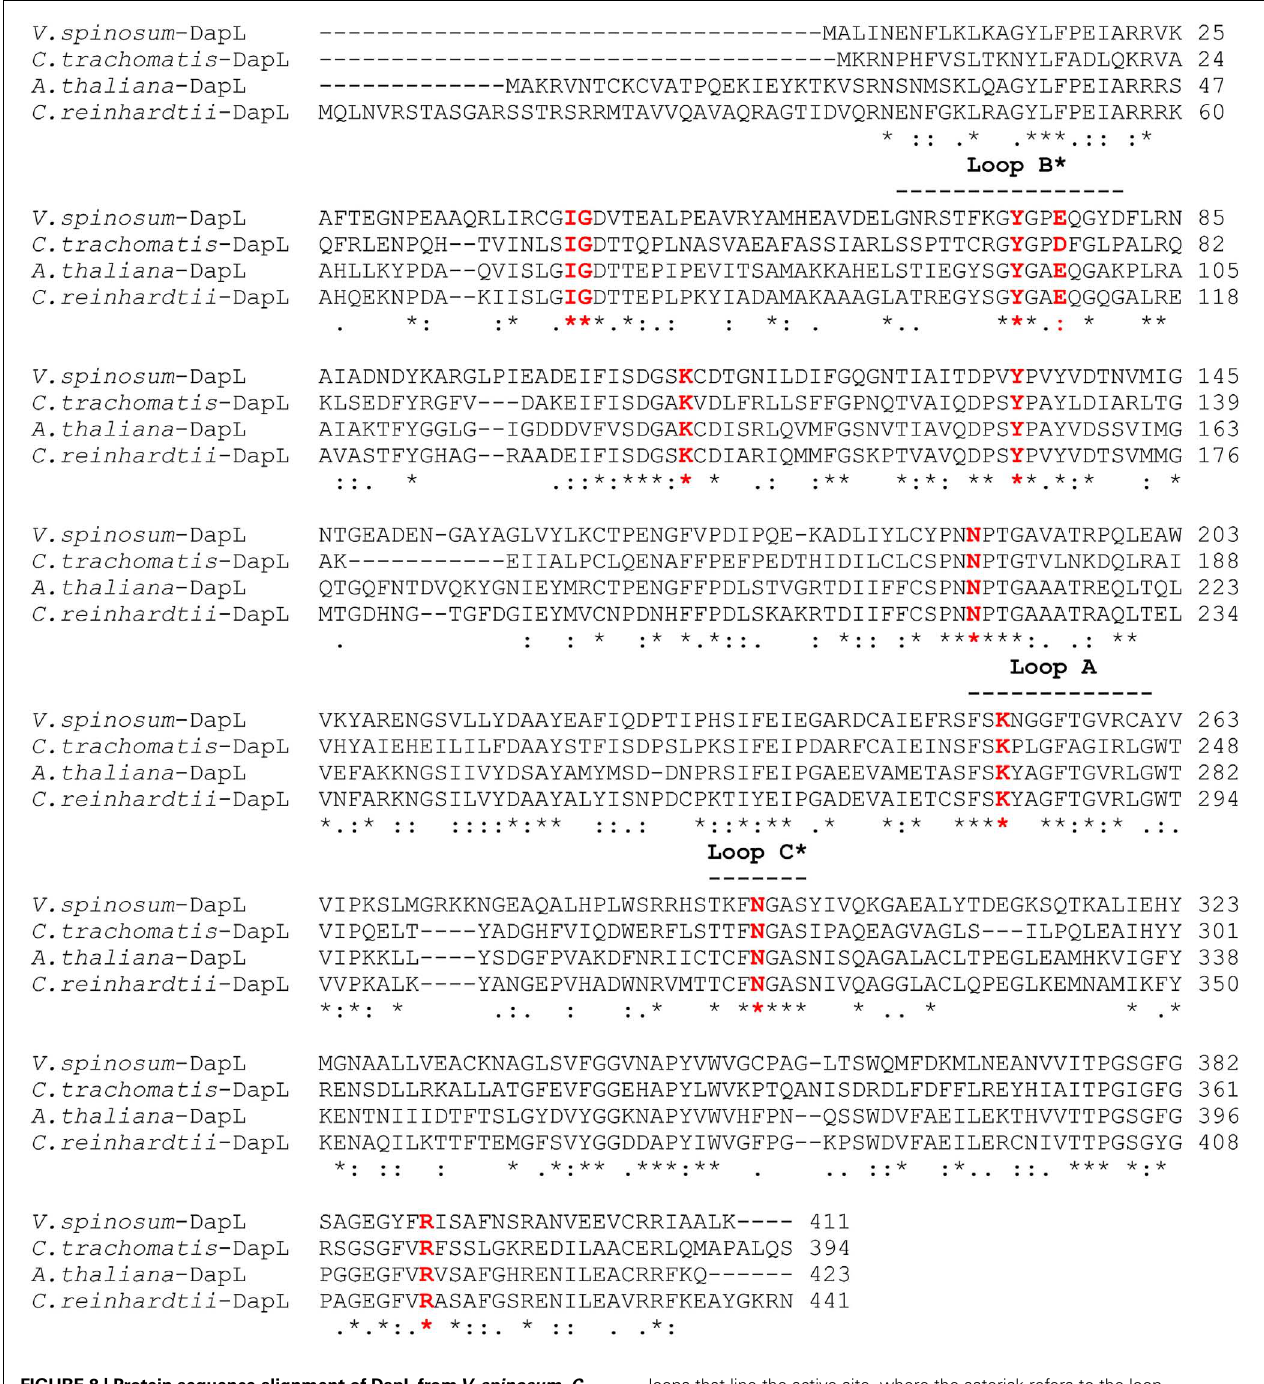
FIGURE 8 | Protein sequence alignment of DapL from V. spinosum, C. trachomatis,A. thaliana , and C. reinhardtii generated using the ClustalW server (http://www.ebi.ac.uk/Tools/msa/clustalw2/). Putative active-site residues, based on the structural studies of the ligand bound At DapL and Cr DapL enzymes, are shown in red.The loop regions correspond to the key